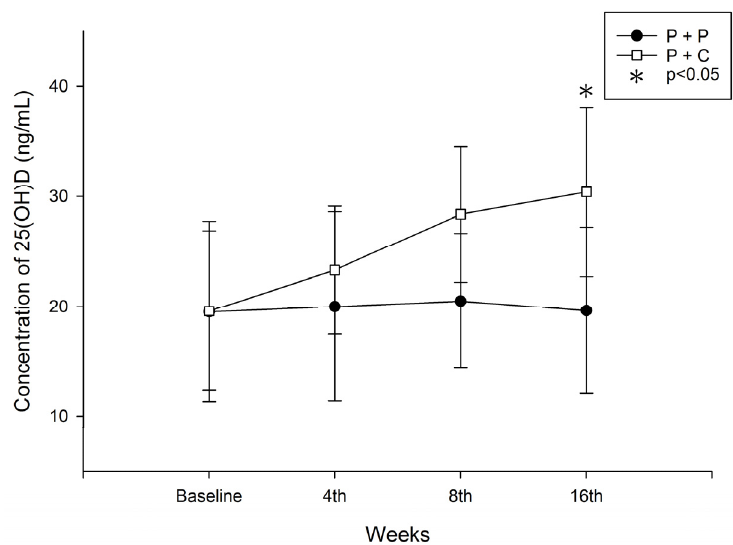
Figure 3. Changes in s erum 25(OH)D 3 levels during study period (P + P: paricalcitol plus placebo; P + C: paricalcitol plus cholecalciferol, * p < 0.05; P + P vs. P + C).